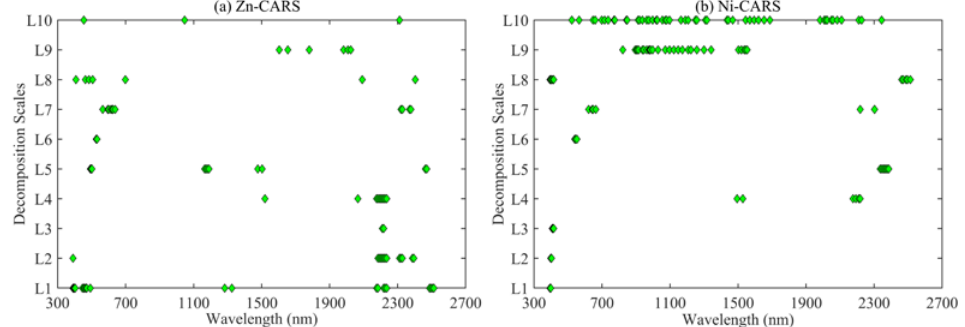
Figure 5. The position of feature bands for Zn and Ni based on the CARS algorithm.